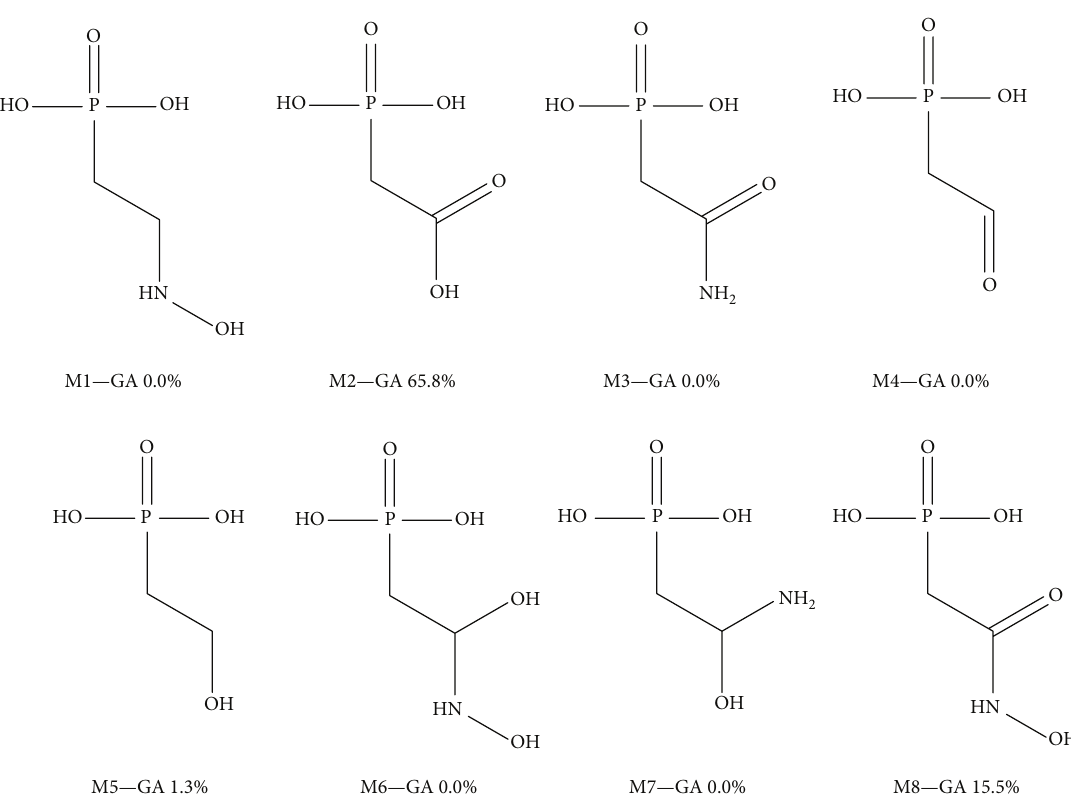
Figure 1: Structure of phosphoethanolamine metabolites and their respective GA (global accumulation). The highest GA for M2 indicates that it is the major metabolite. Table 1: Calculated log 𝑃 and molar refractivity of phosphoethanol- amineandanalogues,phosphoethanolaminemetabolites,andgroup of 8 organophosphorus compounds. Pho: phosphoethanolamine; Pho 01 to Pho 03: phosphoethanolamine analogues; M1 to M8: